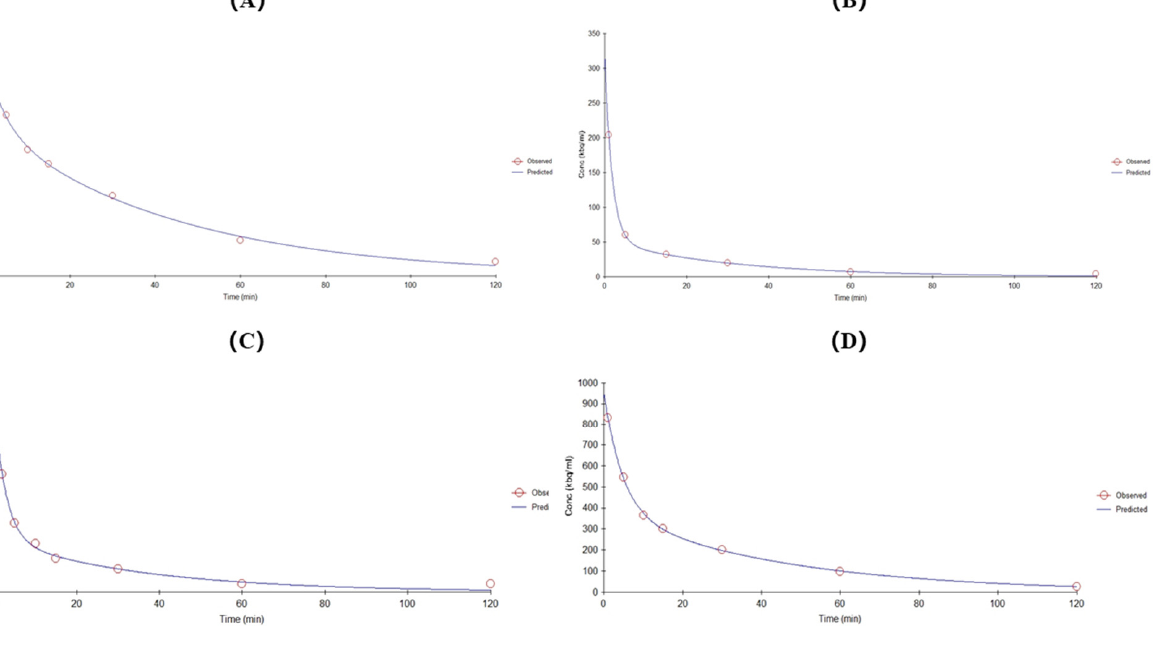
Figure 4. Time-activity curves for [ 177 Lu]Lu-PSMA-BP 29 ( A ), [ 177 Lu]Lu-PSMA-4PY ( B ), [ 177 Lu]Lu-PSMA-Q ( C ) and [ 177 Lu]Lu-PSMA-617 ( D ) in BALB/c mice, respectively.